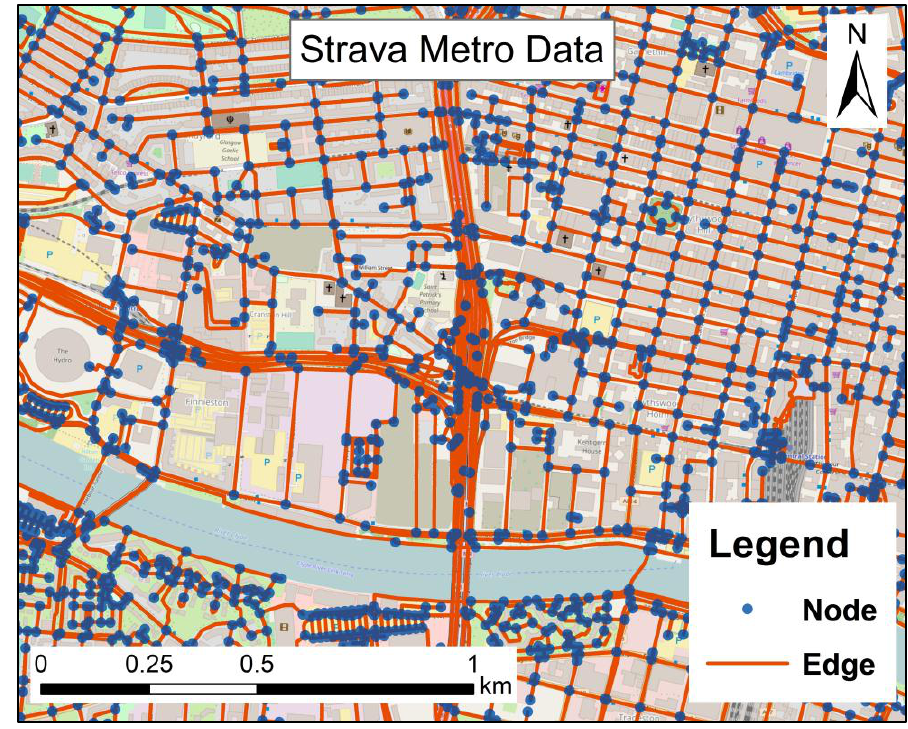
Figure 1. Nodes and edges of Strava Metro data (Basemap: OpenStreetMap, licensed under the Open Database License (ODbL)).